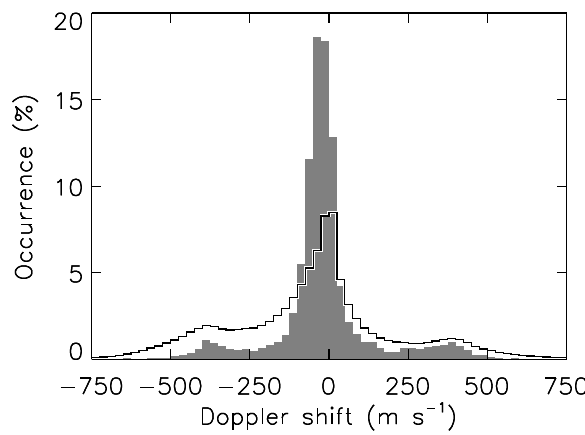
Fig. 6. A comparison of the Doppler shift distribution of E region (solid curve) and D region (grey bars)